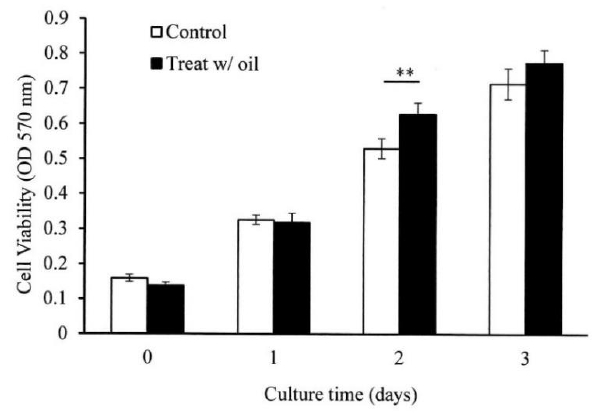
Figure 4. S. mukorossi seed oil significantly increased the viability of CCD-966SK cells by day 2. Data are presented as the mean ± SD. ** p < 0.01.